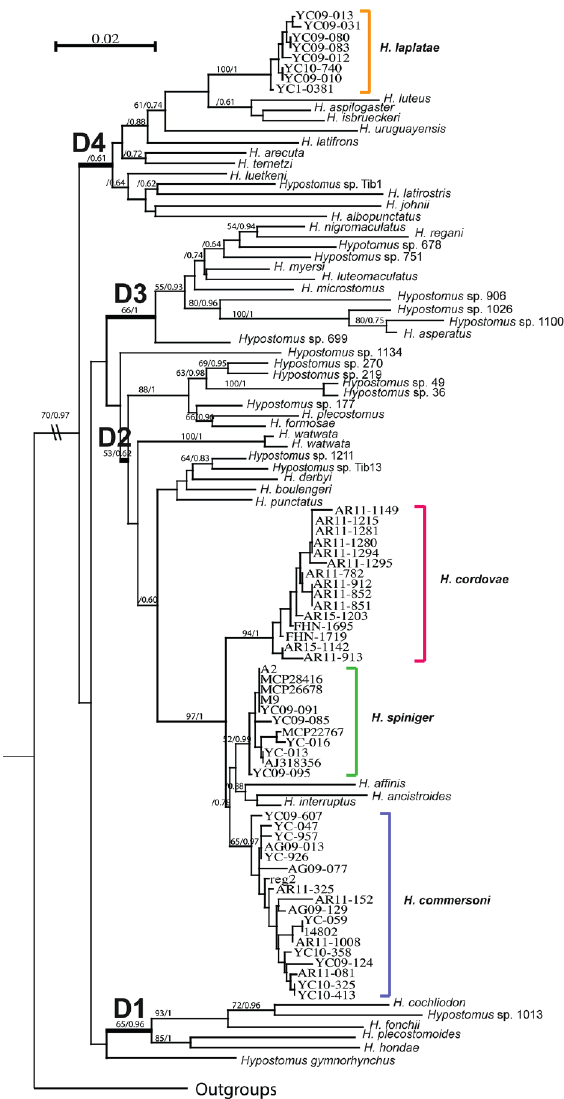
Figure 2 - Maximum likelihood tree based on the mitochondrial D-loop region. Numbers next to branches are bootstrap values (1000 pseudoreplicates) followed by Bayesian posterior probabilities when these are above 50% or 0.5. Specimens of H. laplatae , H. cordovae , H. commersoni and H. spiniger sequenced in this work are in bold and their field number are